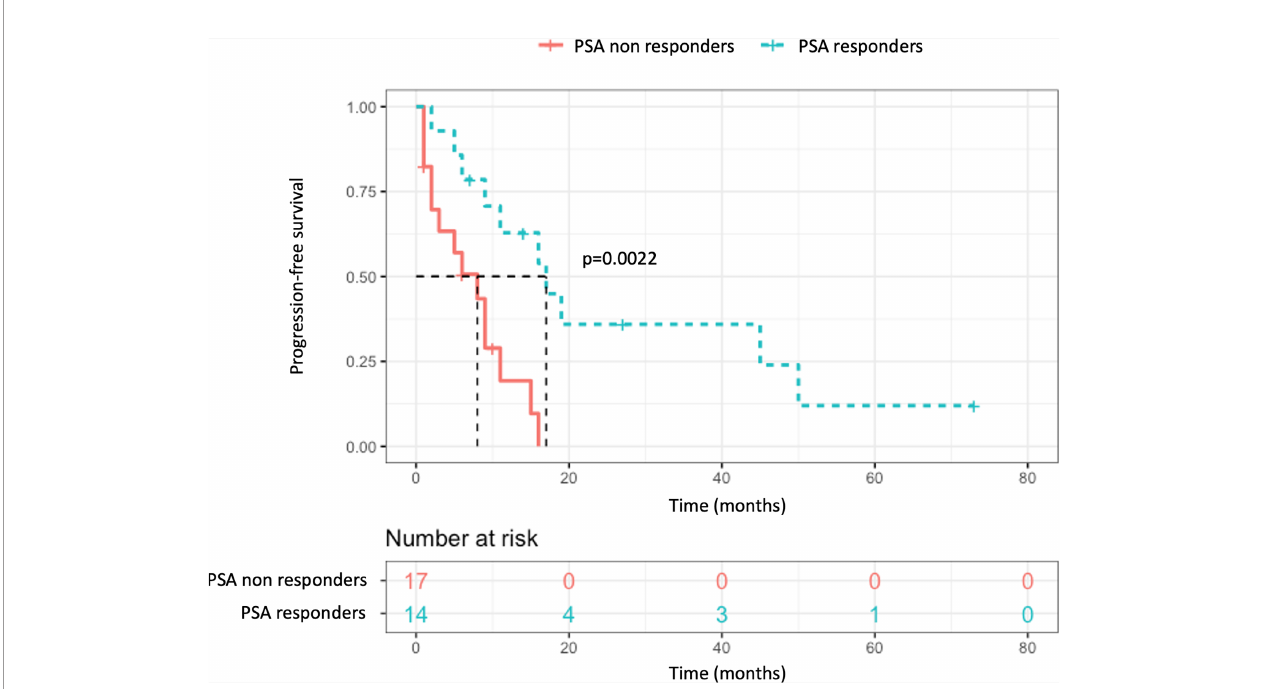
FIGURE 4 | Composite endpoint survival strati fi ed by post-procedure PSA